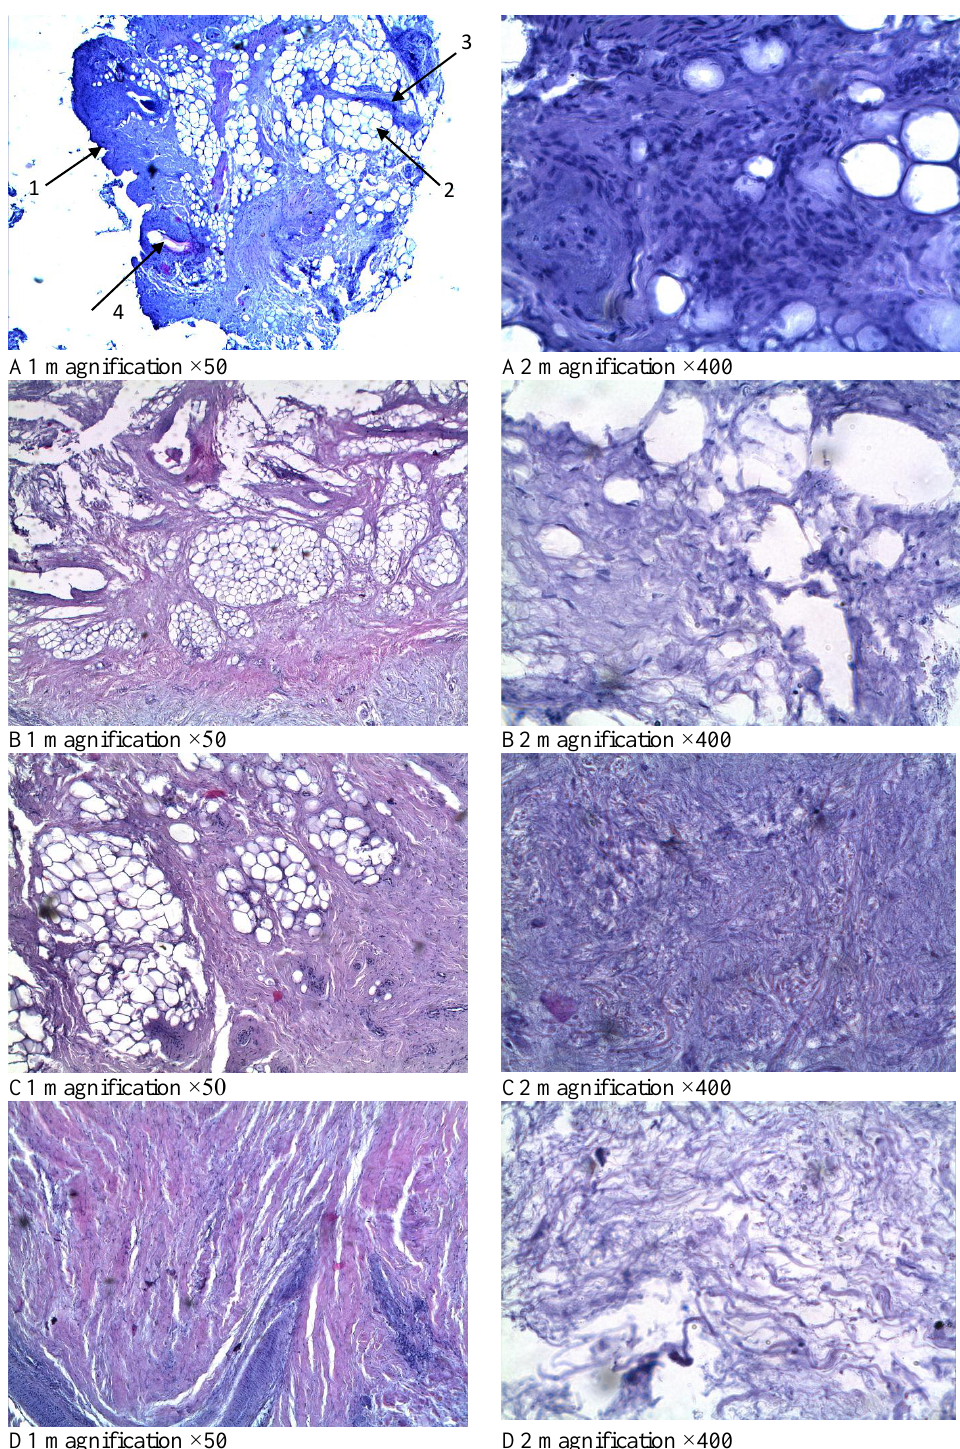
Figure 3. Microstructure of fermented hen combs (hematoxylin-eosin dying). ( A1 , A2 ) control sample in the start time (arrows: 1- folded surface of the skin, 2—layers of adipose tissue, 3—connective tissue septa, 4—lacunae-type blood vessels); ( B1 , B2 ) fermented control sample; ( C1 , C2 ) fermented test sample with BLC; ( D1 , D2 ) fermented test sample with Propionix LCSC. Partial loss of tissue structural units, monotony of coloring and poor perception of histological dyes were found in histosections of control fermented samples (Figure 3(B1)), as well as a few weakly stained cell nuclei with fuzzy, blurred borders (Figure